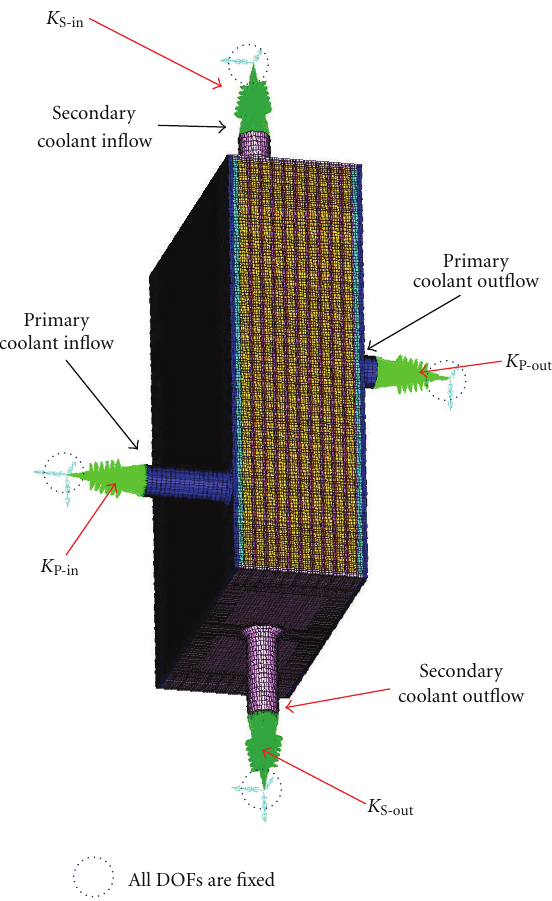
Figure 14: Suggested boundary